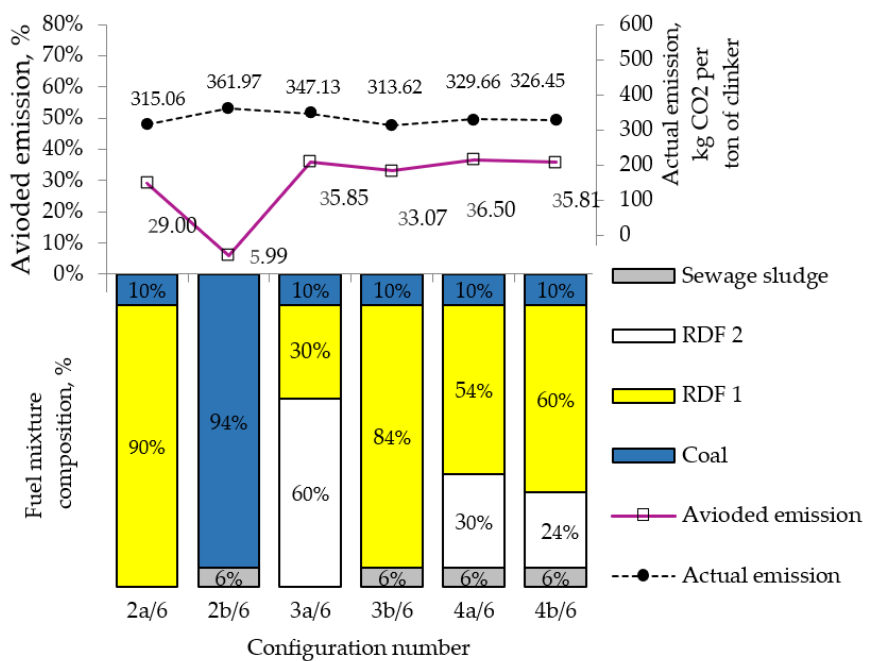
Figure 3. The comparison of the level of CO 2 reduction for the different co-combustion configura- tions of coal with RDFs or sewage sludge